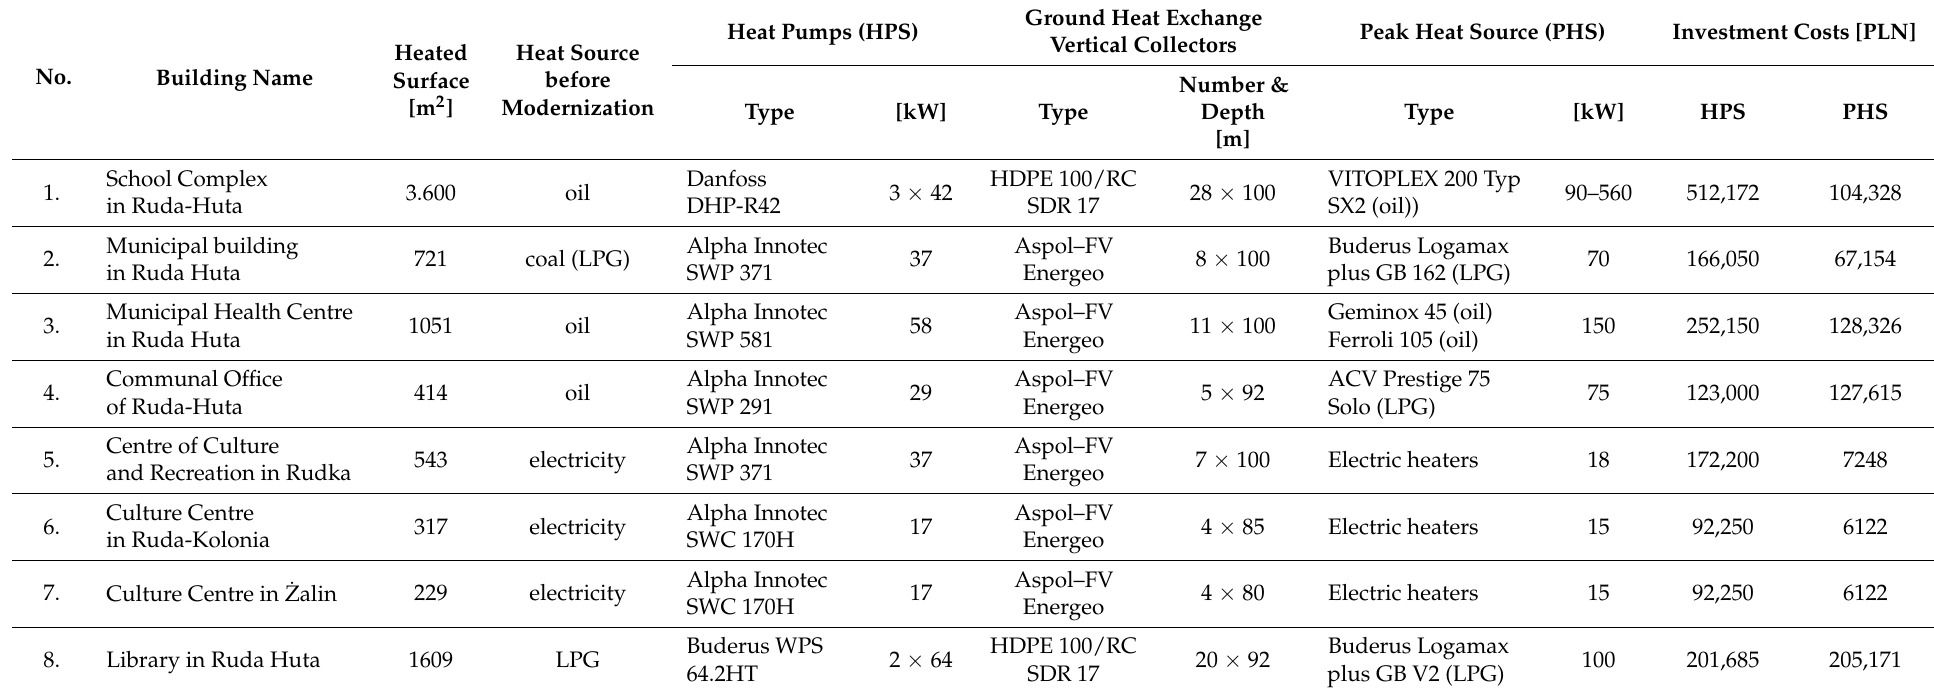
Table 2. Selected technical and economic parameters associated with each municipal